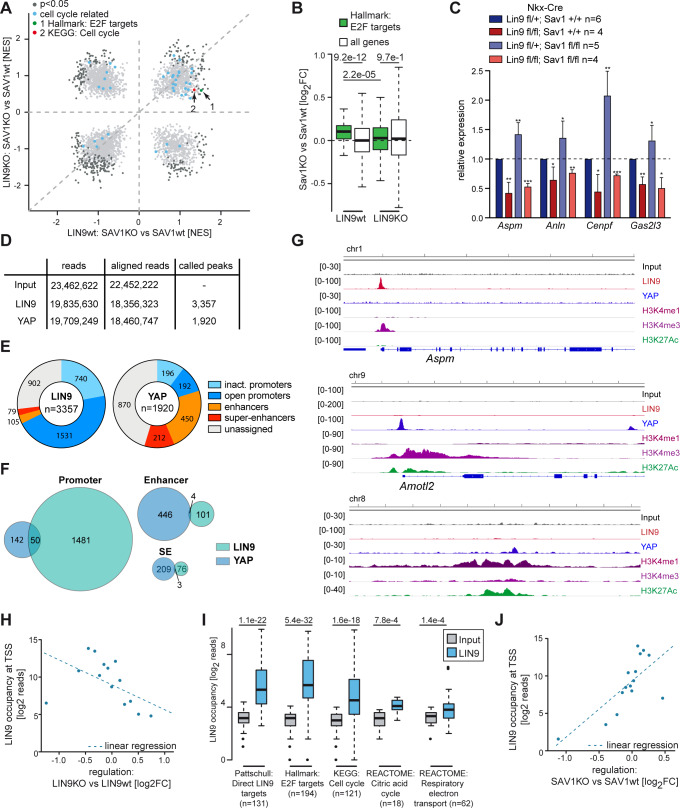
Cell cycle genes upregulated in Sav1 knockout hearts are direct targets of LIN9.A) GSEA comparing the effect of deletion of Sav1 in Nkx-Cre LIN9 wt and LIN9 KO heart ventricles at E13.5. Gene sets related to cell cycle are highlighted in blue. NES: normalized enrichment score. B) Boxplot comparing differences in E2F target gene expression between Nkx2.5-Cre; Sav1fl/fl (Sav1 KO) and Nkx2.5-Cre; Sav1+/+ (Sav1 wt) heart ventricles in Lin9fl/fl (LIN9 KO) or Lin9fl/+ (LIN9 wt) background. C) Expression of the indicated genes relative to actin and Hprt in heart ventricles of embryos with the indicated genotypes was analyzed by RT-qPCR. D) E16.5 hearts were subjected to ChIP-seq using antibodies specific for LIN9 and YAP. The table shows the number of reads, aligned reads and called peaks. E) Genomic localization of LIN9 and YAP in fetal (E16.5) heart ventricles. Active promoters, enhancers and super-enhancers are defined based on publicly available ChIP-seq data for histone marks. F) Venn diagram showing the overlap between binding by LIN9 and YAP in E16.5 hearts. G) Genome browser tracks illustrating the binding of LIN9 to the Aspm promoter and binding of YAP to the Amotl2 promoter and to an intergenic enhancer. ChIP-seq data for histone modifications are from ENCODE (GSE31039). Additional examples are shown in S2D Fig. H) Bin plot correlating changes in gene expression in Nkx-Cre; Lin9fl/fl heart ventricles with binding of LIN9 to the promoter. Analyzed was a region 1kb upstream the TSS and input signals were subtracted. 15,642 expressed genes were grouped into 15 bins and the mean of each bin is plotted. Dashed line: Regression based on a linear model. I) Boxplot depicting LIN9 binding to genes from the gene sets shown in S2A and S2D Fig. Analyzed was a region of +/-250bp around the TSS. J) Bin plot correlating changes in gene expression after Sav1 knockout in Nkx2.5-Cre hearts with binding of LIN9 to the promoters at E16.5. Analysis was performed as in H.